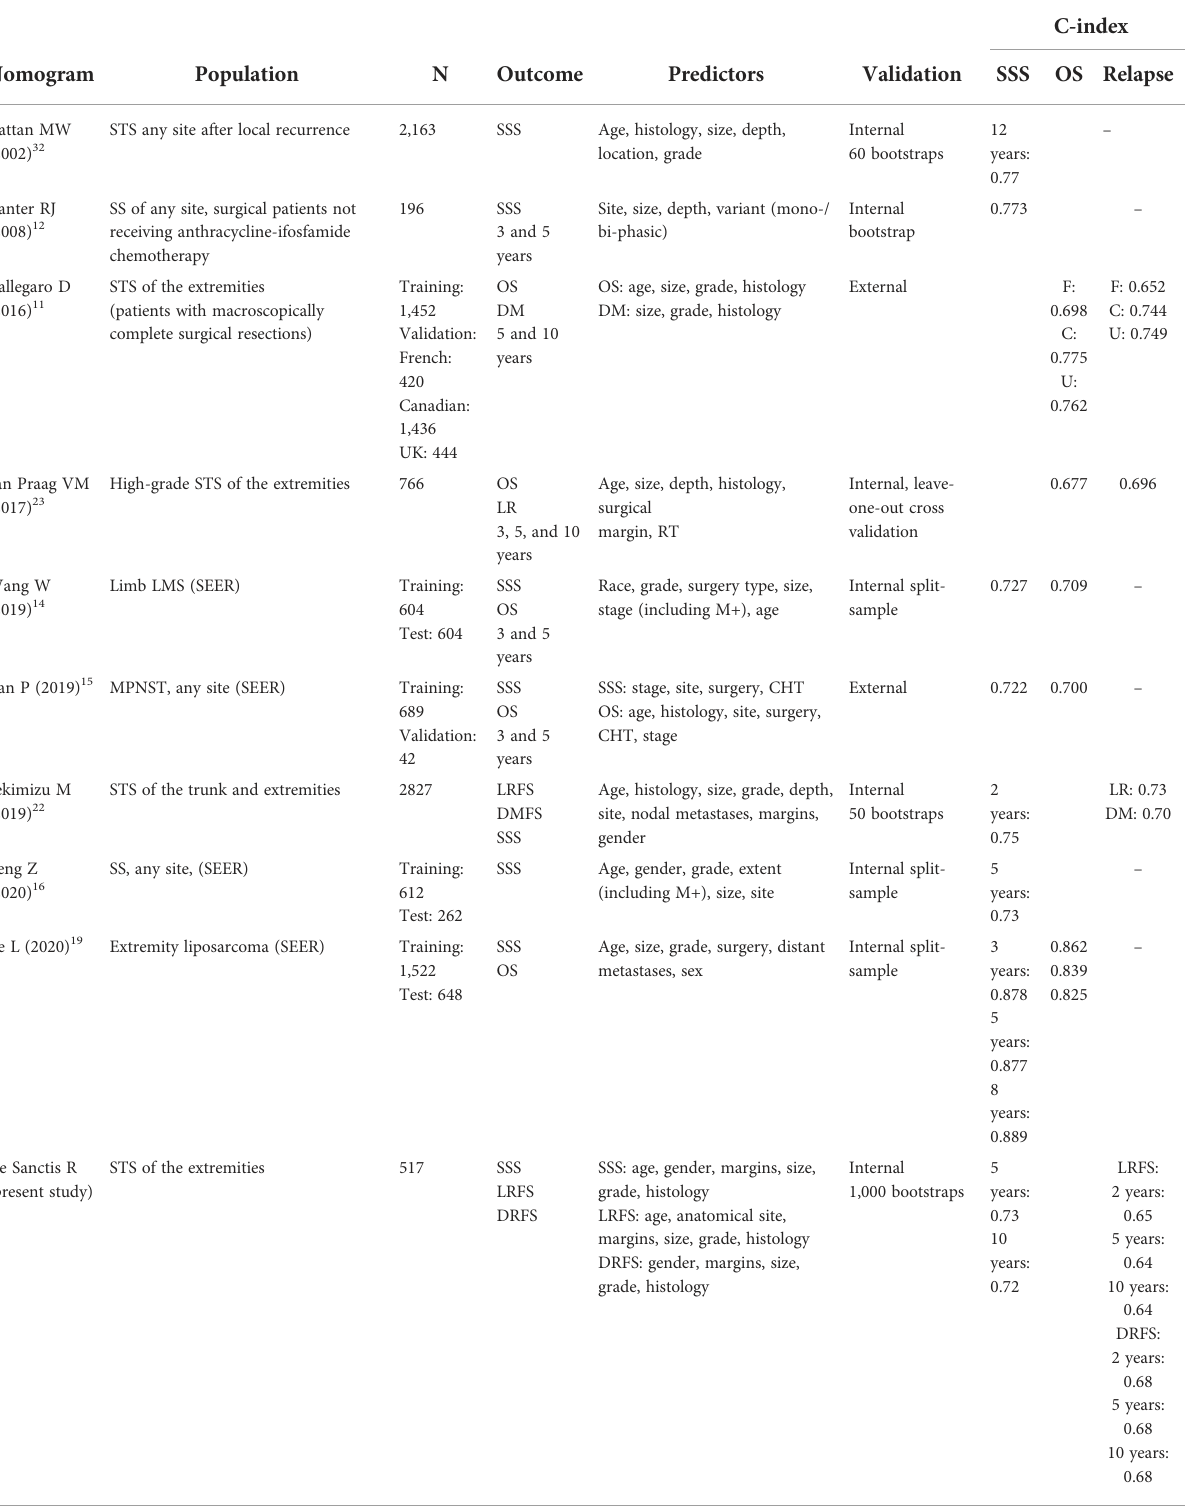
TABLE 5 Clinical studies on STS